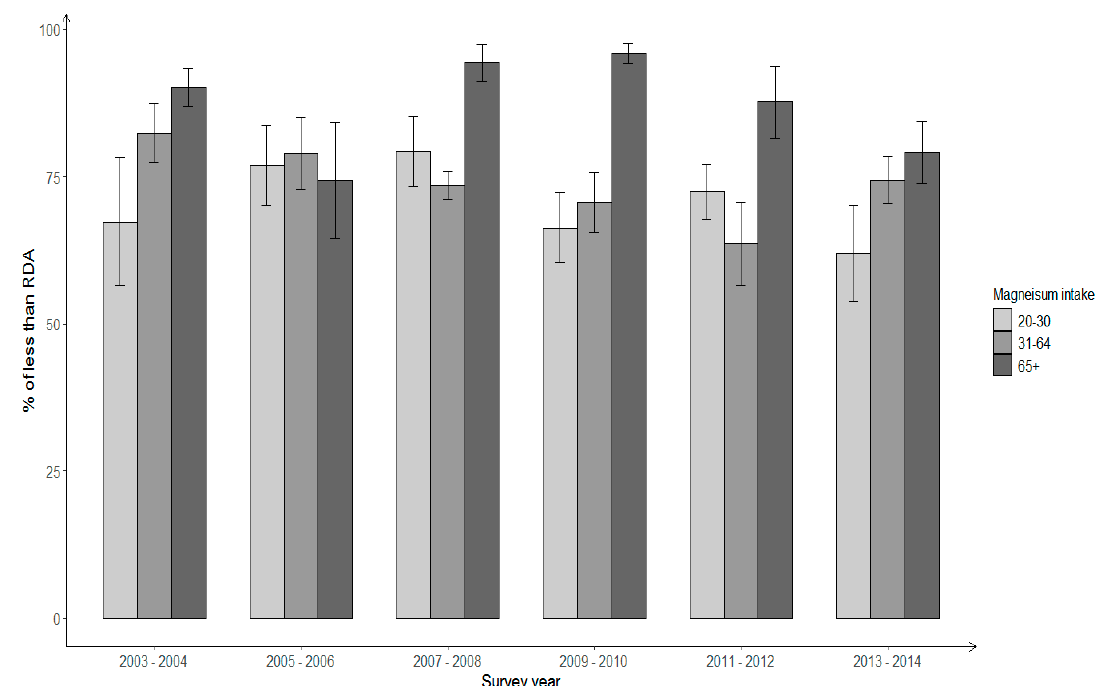
Figure 2. Percentage of insufficient total magnesium intake among Hispanic males by age groups across NHANES survey years 2003–2014. Nutrients 2019 , 11 , x FOR PEER REVIEW